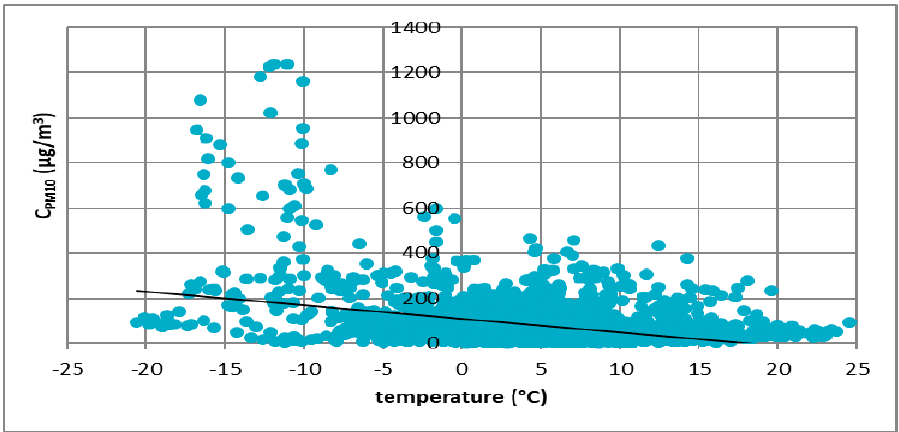
Figure 5. The e ff ect of temperature on PM10 concentration in Zabrze in 2017. Figure 5. The effect of temperature on PM10 concentration in Zabrze in 2017. Figure 5. The effect of temperature on PM10 concentration in Zabrze in 2017.